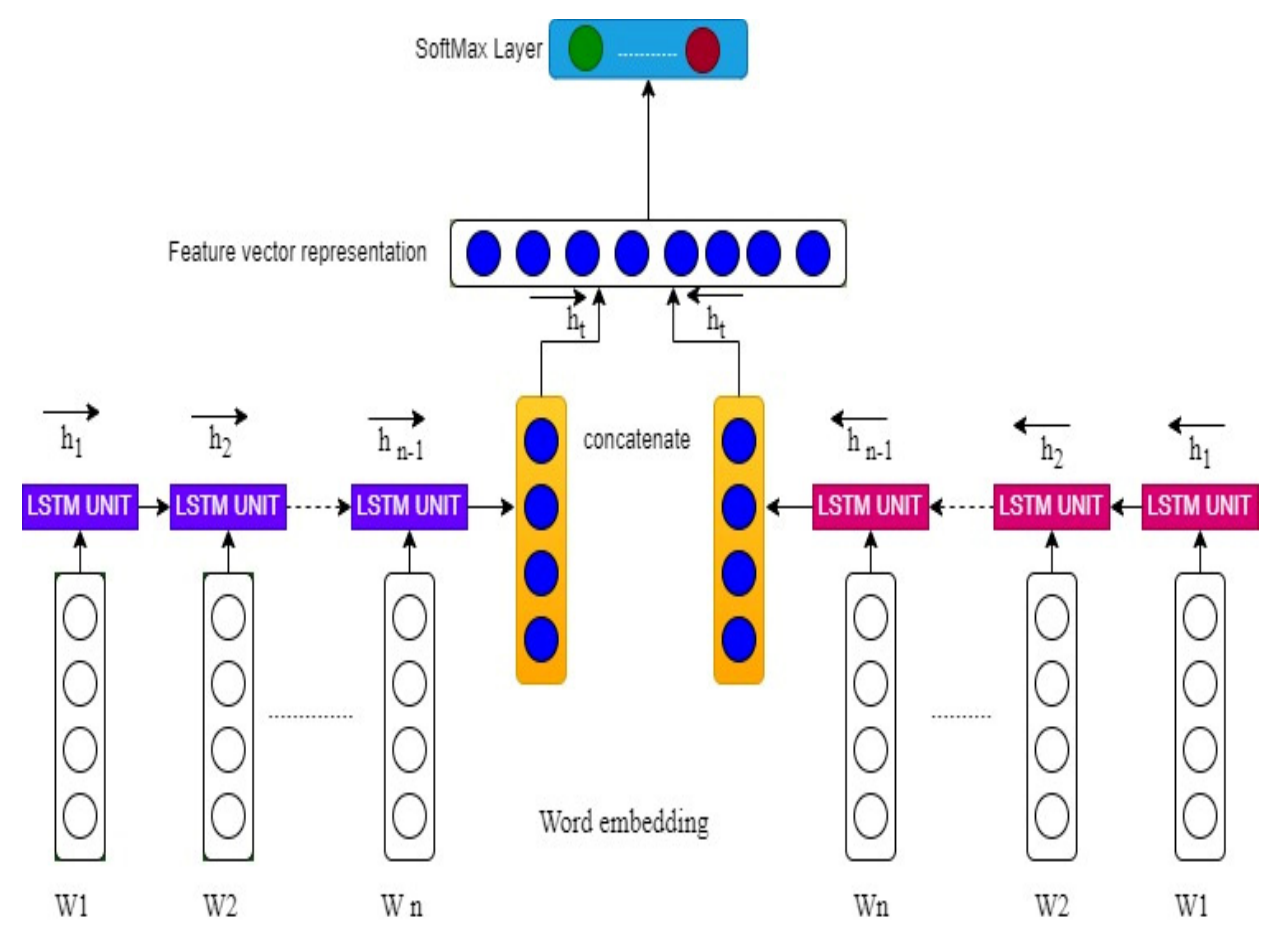
Figure 3. Structure of the BiLSTM model for cyberbullying detection.